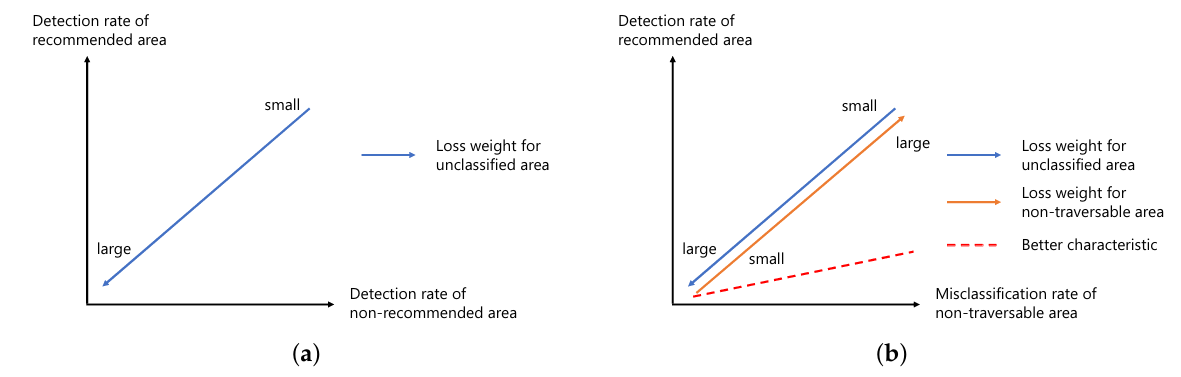
Figure 17. Trade-off by loss weighting: ( a ) trade-off between detection rate of non-recommended area and detection rate of recommended area; and ( b ) trade-off between misclassification rate of non-traversable area and detection rate of recom- mended area.